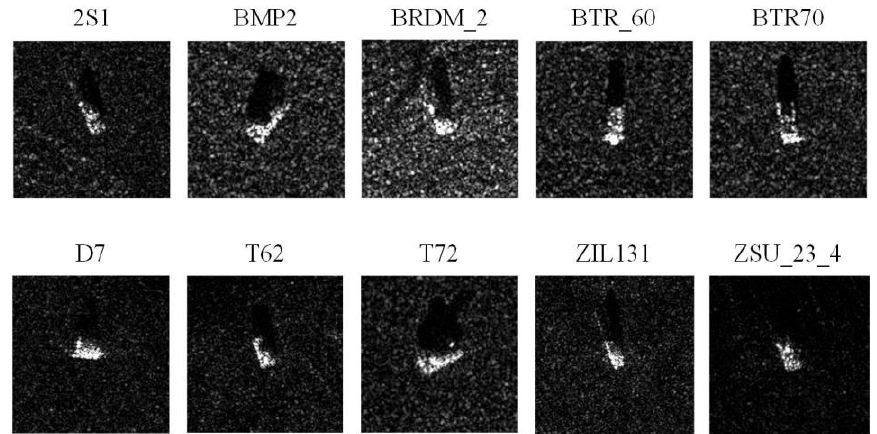
Figure 5. Example images from the MSTAR dataset. Table 2. Details of FURSAR-Ship, including target class and data number.